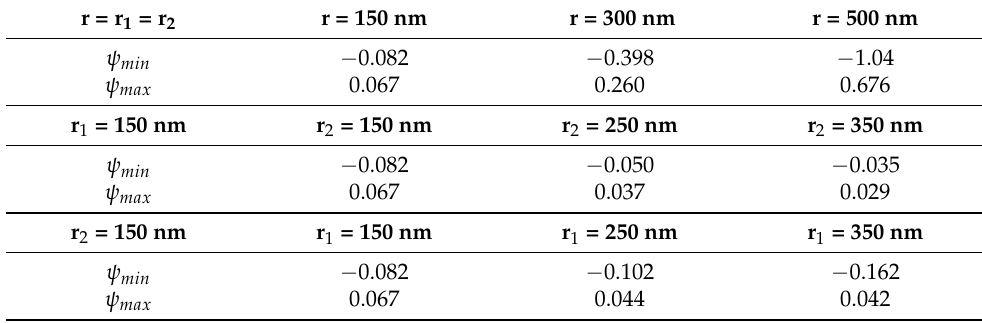
Table 2. Electric potential ranges ψ for the different NP